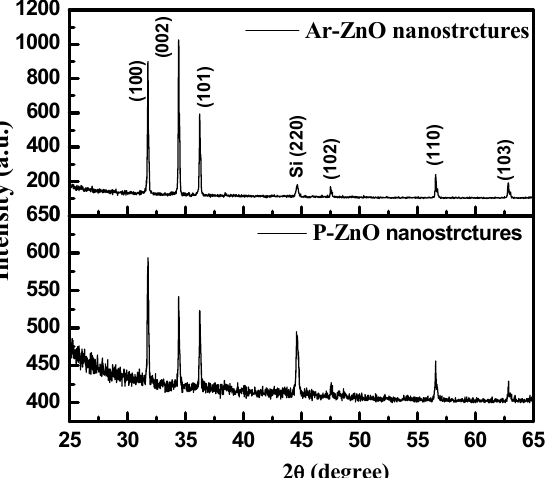
Figure 1. XRD patterns for pristine ZnO and Ar-ZnO nanowires grown on Si(100) substrate.